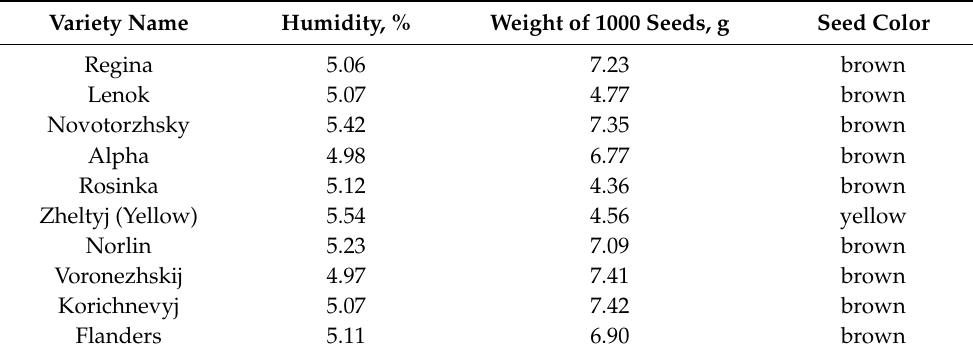
Table 1. Characteristics of flax seeds of the studied